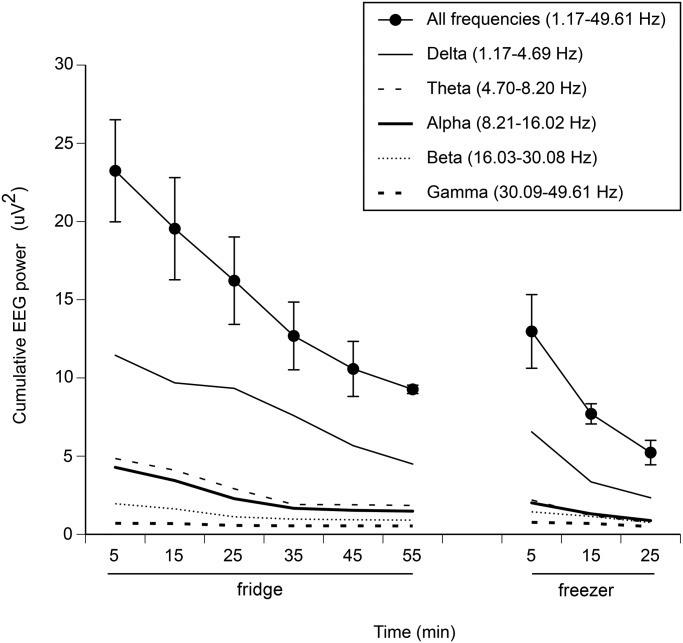
Changes in brain activity measured as cumulative EEG power, and delta, theta, alpha, beta and gamma power, as a function of time spent in the new thermal regime. Across all frequency bandwidths, brain activity shows a smooth decline across the first 60 min in the fridge and 30 min in the freezer (means and standard errors). X-axis shows midpoint time for each 10-min period.